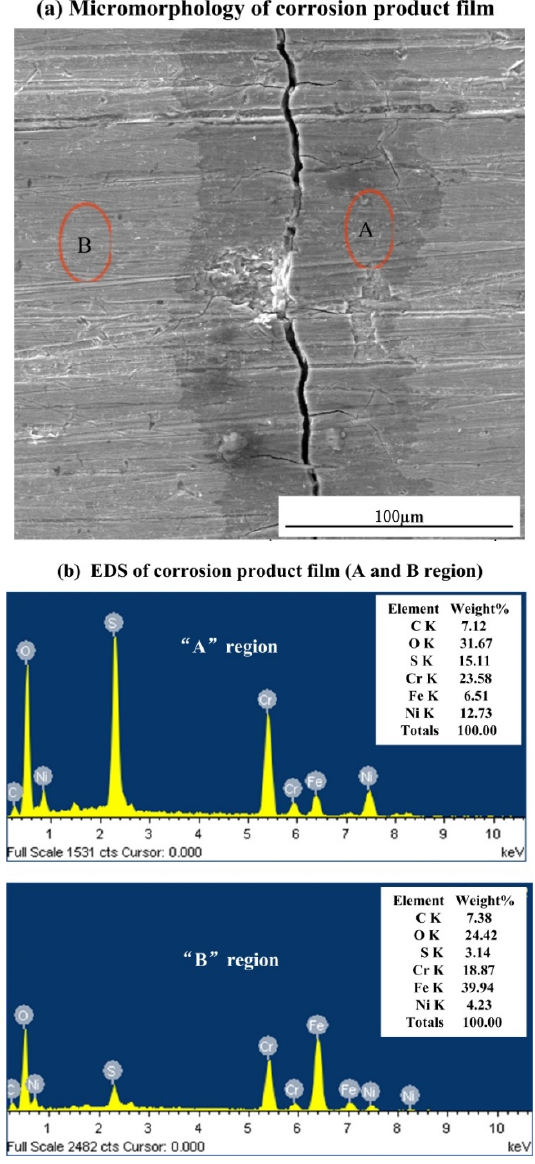
Figure 6. Surface morphologies ( a ) corrosion products of two different regions near the crack and ( b ) Energy ‐ dispersive spectroscopy (EDS) analyses.